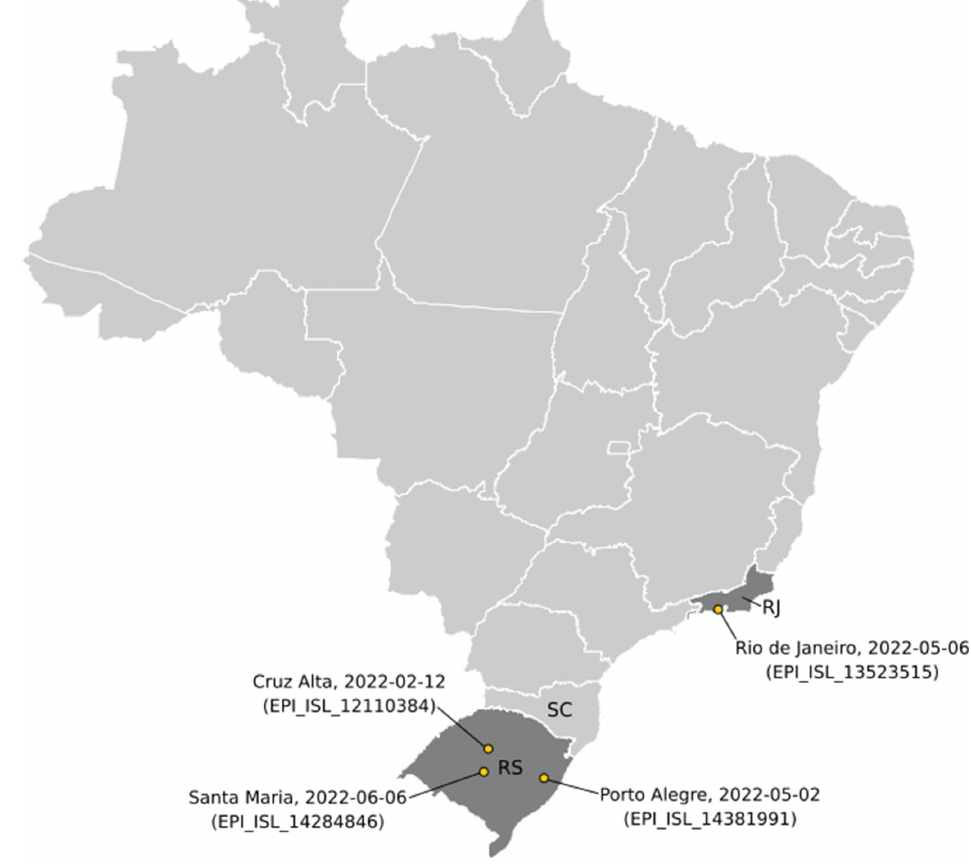
Figure A2. Origin of the Brazilian Deltacron samples. Map of Brazil showing where the Brazilian Deltacron samples were collected (yellow points) with their respective collection dates. GISAID accession numbers are in parentheses.